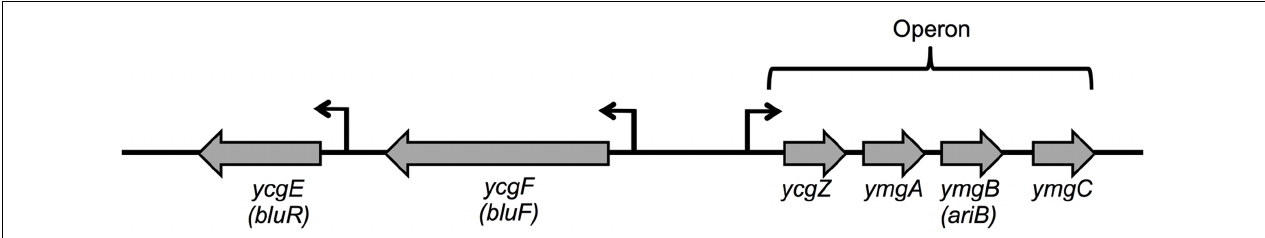
FIGURE 1 | Organization of ycgZ-ymgABC , ycgE , and ycgF ORFs in Escherichia coli . The bent arrows indicate the transcription start for each gene. ycgZ , ymgA , ymgB , and ymgC genes are expressed as one transcript. ycgE , ycgF , and ymgB have been renamed bluR , bluF , and ariB , respectively.